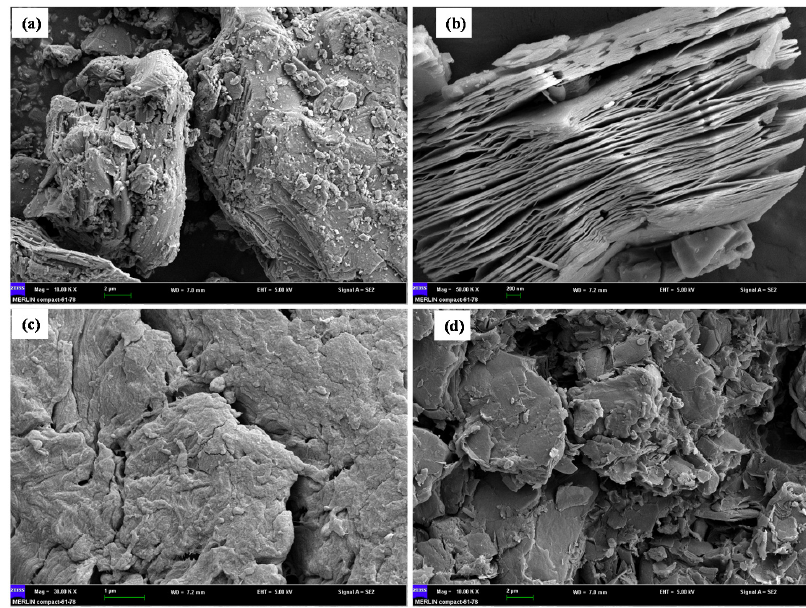
Figure 2. SEM images of the original Ti 3 AlC 2 ( a ) , the Mxene ( b ), CS ( c ), and prepared Mxene–CS ( d